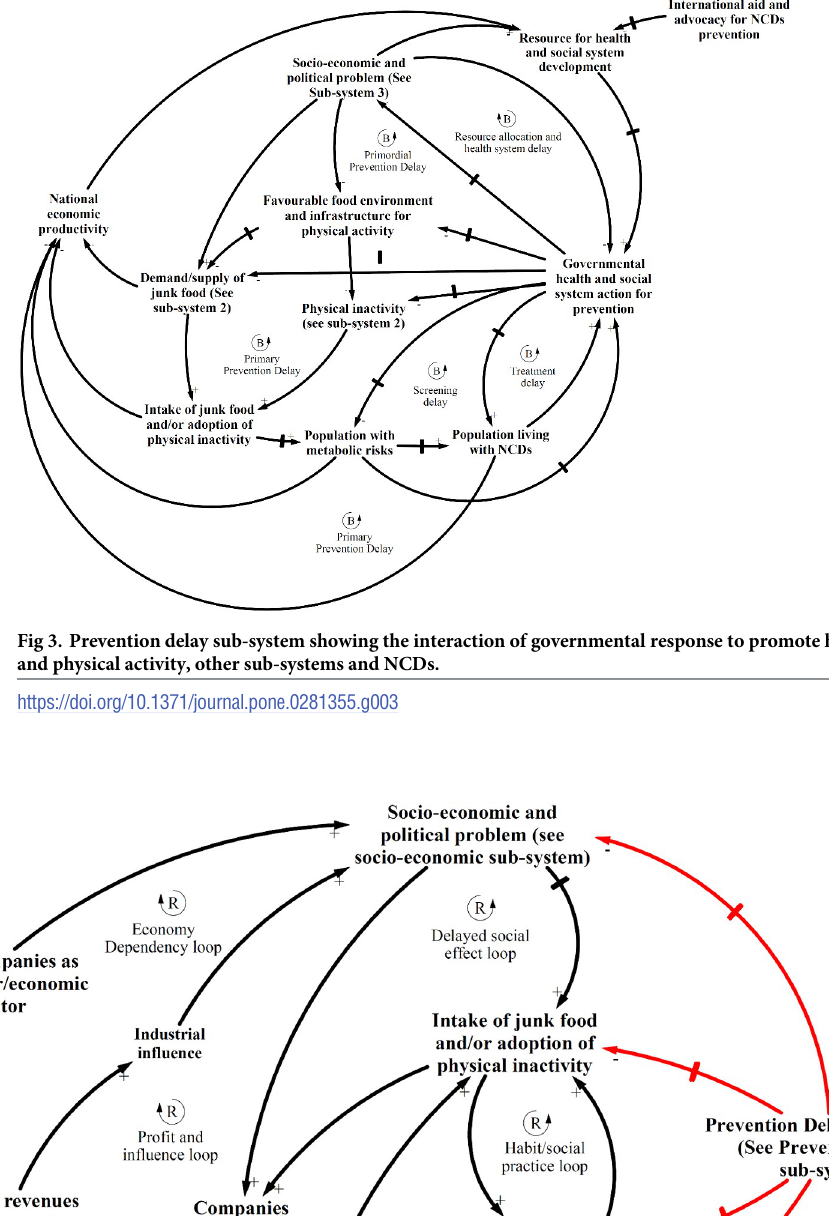
PLOS ONE | https://doi.org/10.1371/journal.pone.0281355 February 6,